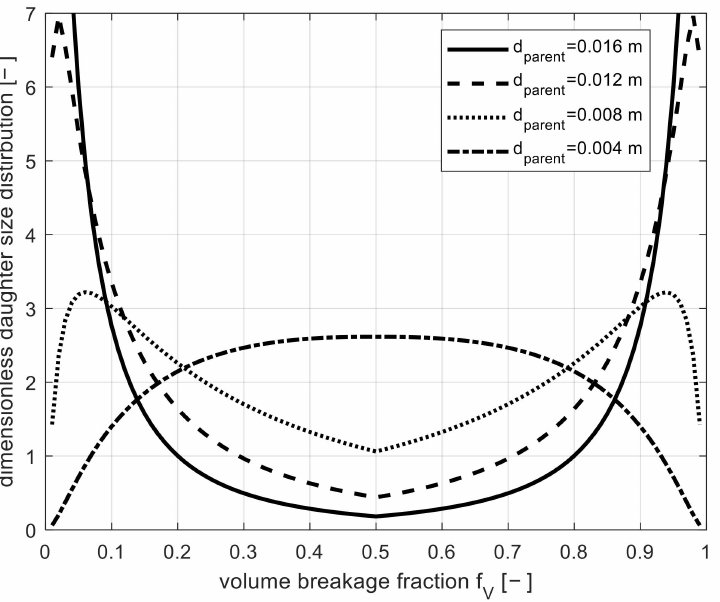
Figure 5. Prediction of daughter size distributions using the approach of Lehr et al. for different parent bubble sizes with the set value ε = 0.1 W m − 3